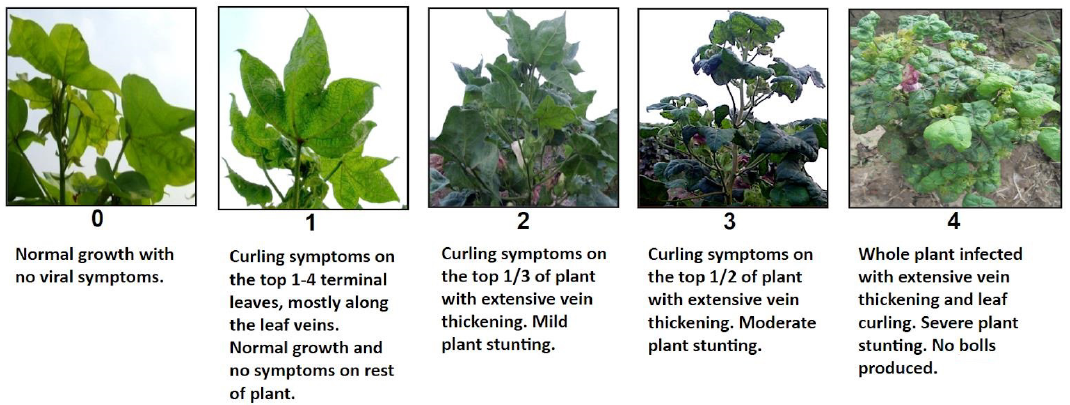
Figure 1. Disease scale used to score for cotton leaf curl virus (CLCuV) symptom severity. Plants were rated on a scale of 0 to 4, where 0 = no symptoms of CLCuV and 4 = severe leaf curling and very reduced boll